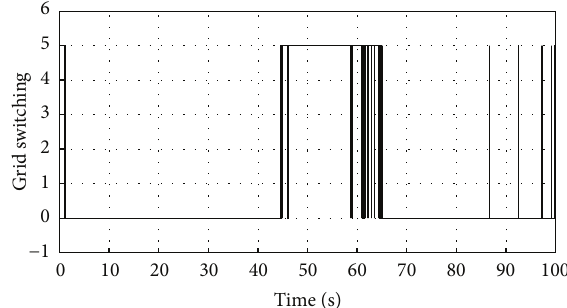
Figure 26: Switching instants of utility grid when wind and solar energy are not sufficient.